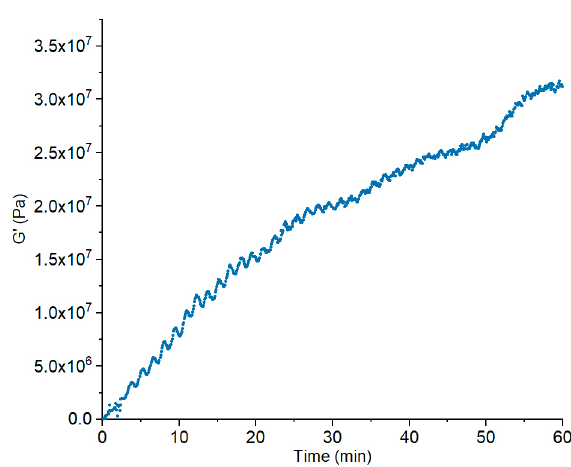
Figure 9. Storage modulus (G') of the rehydrated paste as a function of time.